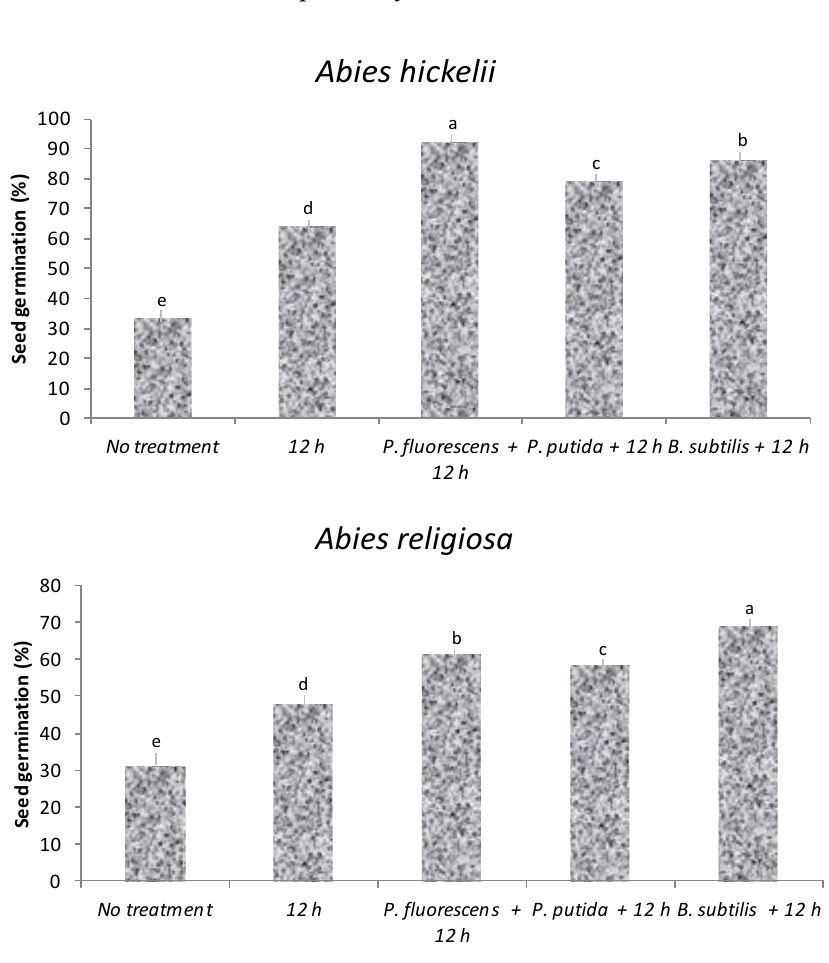
Figure 2. Germination percentage with both hydropriming and biopriming for seeds of Abies religiosa and A. hickelii. No treatment = Control, only moistened with sterile distilled water. 12 h = hydropriming with a constant flow of 2.5–4 L·min −1 distilled water and air, biopriming was carried out with Pseudomonas fluorescens strain JUV8, P. putida strain PpUV1 and Bacillus subtilis strain BsUV in suspension of 10 mL for 15 min. All biopriming seeds also included 12 h of prior hydropriming. Percentage of germination was evaluated after depositing seeds on sterile wet absorbent paper for 30 days at 20 °C. Different letters indicate statistical differences ( p ≤ 0.05). Error bars represent standard deviation